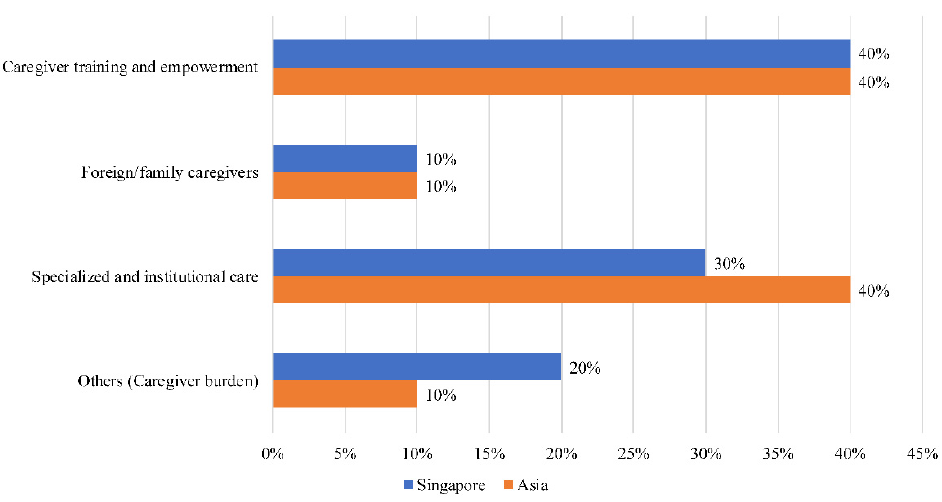
Figure 7. Societal narratives on caregivers in Singapore.